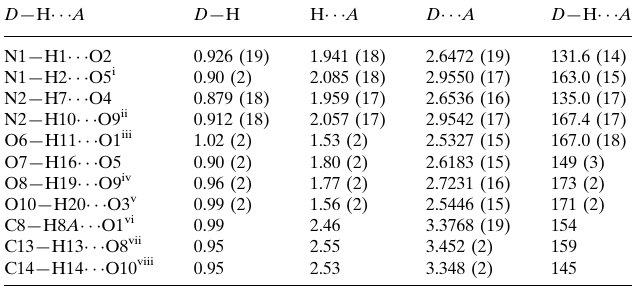
Hydrogen-bond geometry (A˚ , (cid:3)